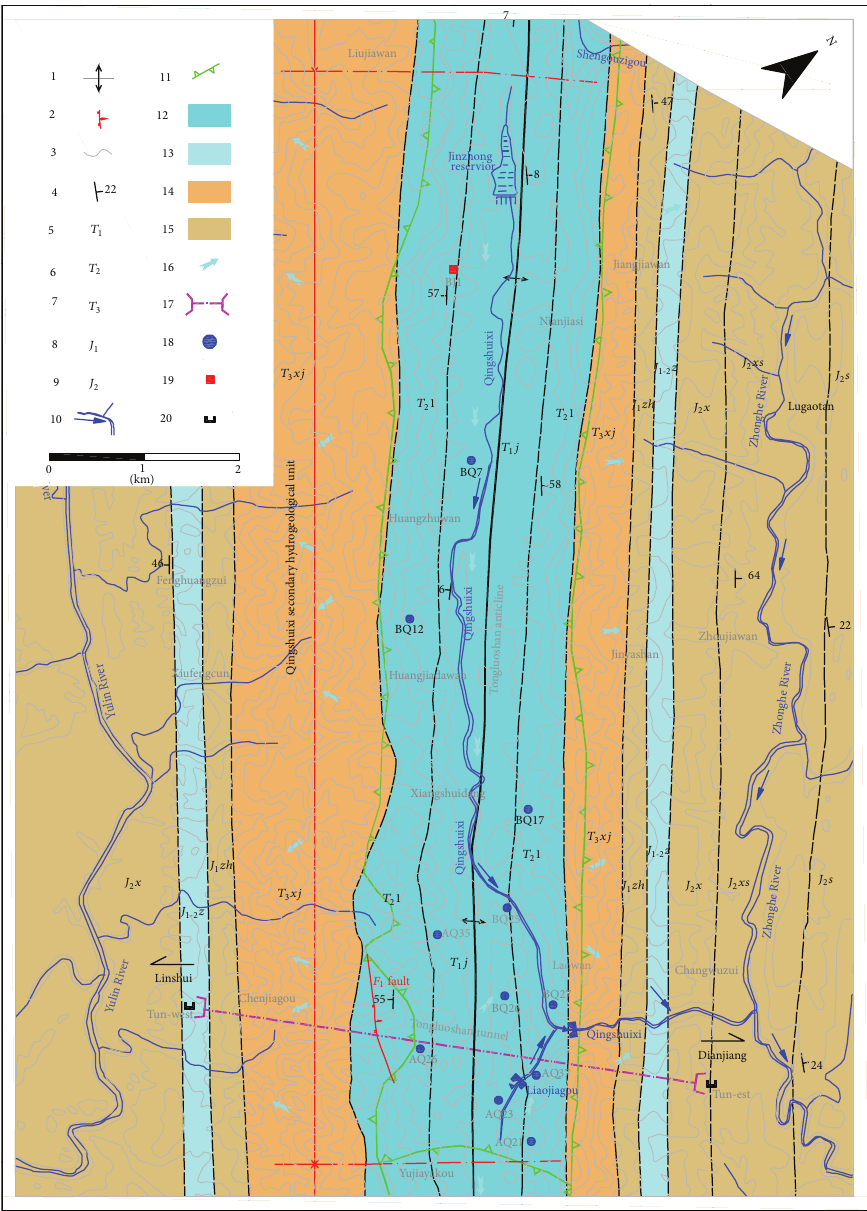
Figure 3: Map showing hydrogeological features and observation points in the project area. 1: anticline; 2: fault; 3: stratigraphic boundary; 4: attitude of strata; 5: lower Triassic; 6: middle Triassic; 7: upper Triassic; 8: lower Jurassic; 9: upper Jurassic; 10: river and its flow direction; 11: watershed; 12: limestone and dolomite; 13: carbonate rocks interbedded with mudstone; 14: sandstone; 15: mudstone interbedded with siltstone; 16: flow direction of groundwater; 17: tunnel; 18: spring; 19: well; 20: drainage from